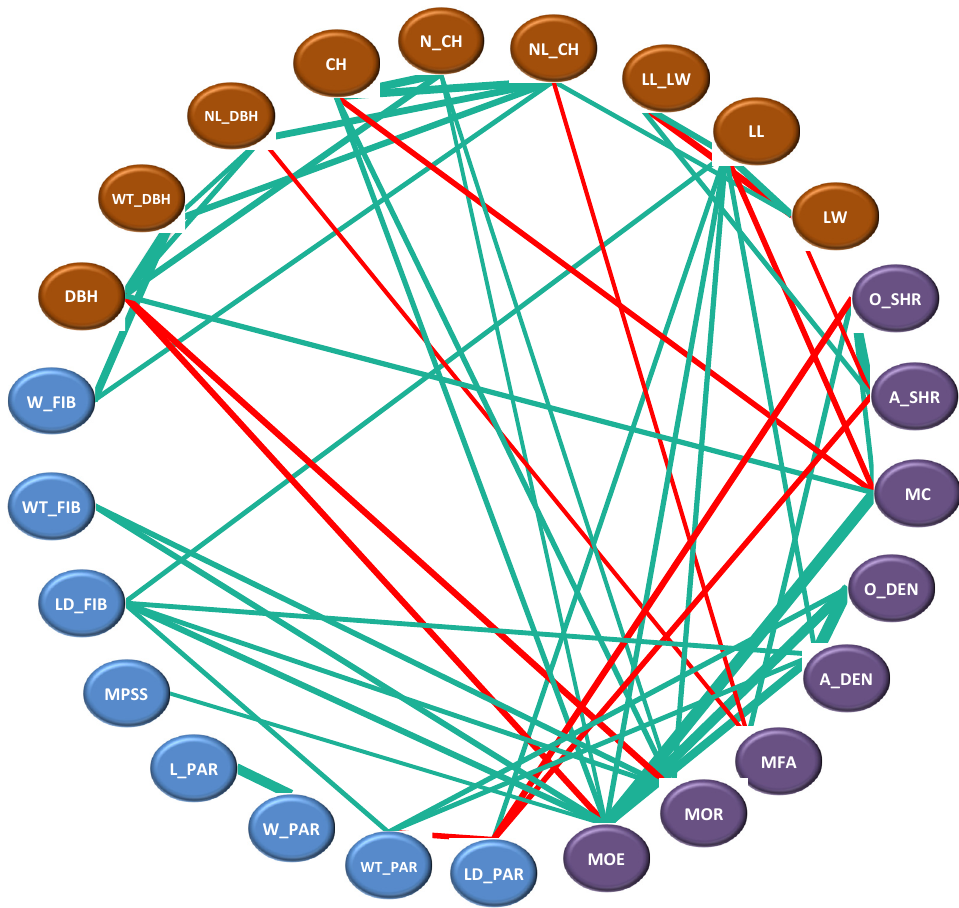
Figure 6. Summary of correlation analysis about 28 traits in Moso bamboo ( Phyllostachys edulis ).